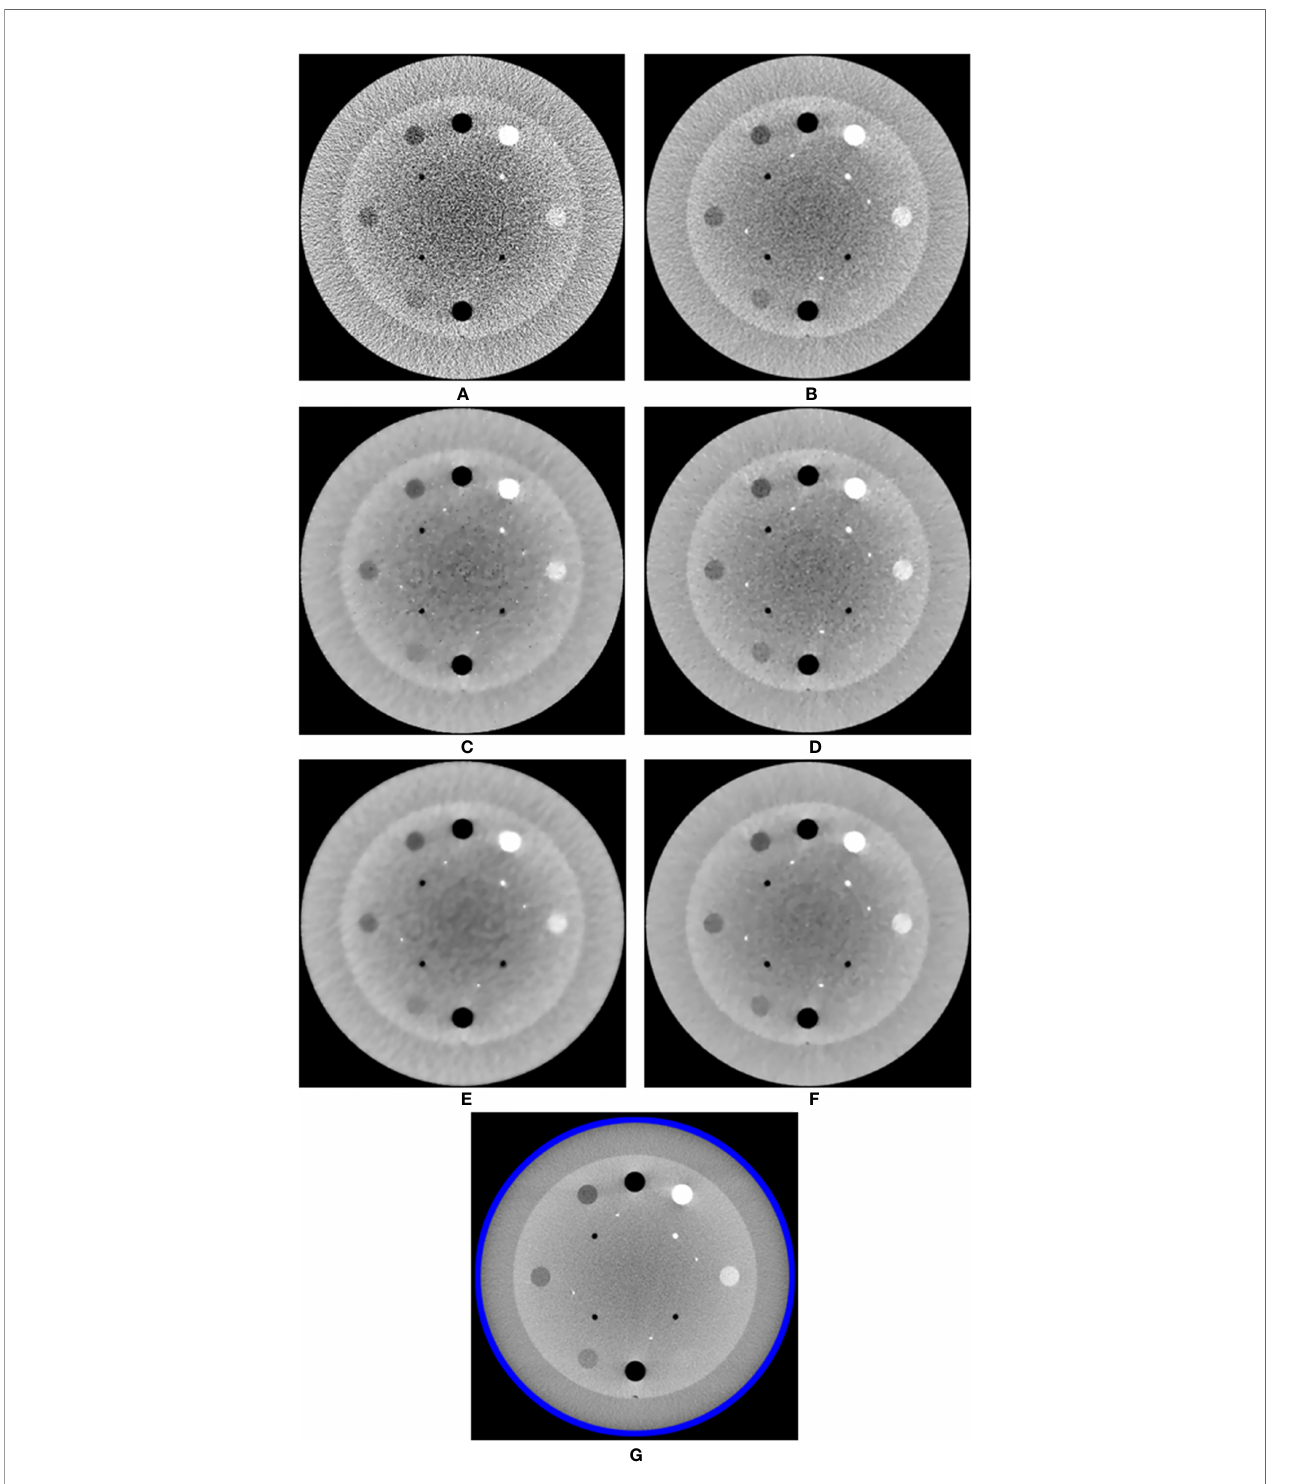
FIGURE 2 | Comparison between the same views of the CBCT images generated by applying the analytical reconstruction algorithm based on (A) PDB, (B) RDB, (C) PDB followed by NLTV, (D) RDB followed by NLTV, (E) PDB followed by MI-NLTV, and (F) RDB followed by MI-NLTV using the Catphan ® 503 phantom. (G) Benchmark image. These images are displayed at the window width (975 HU) and the window level (0